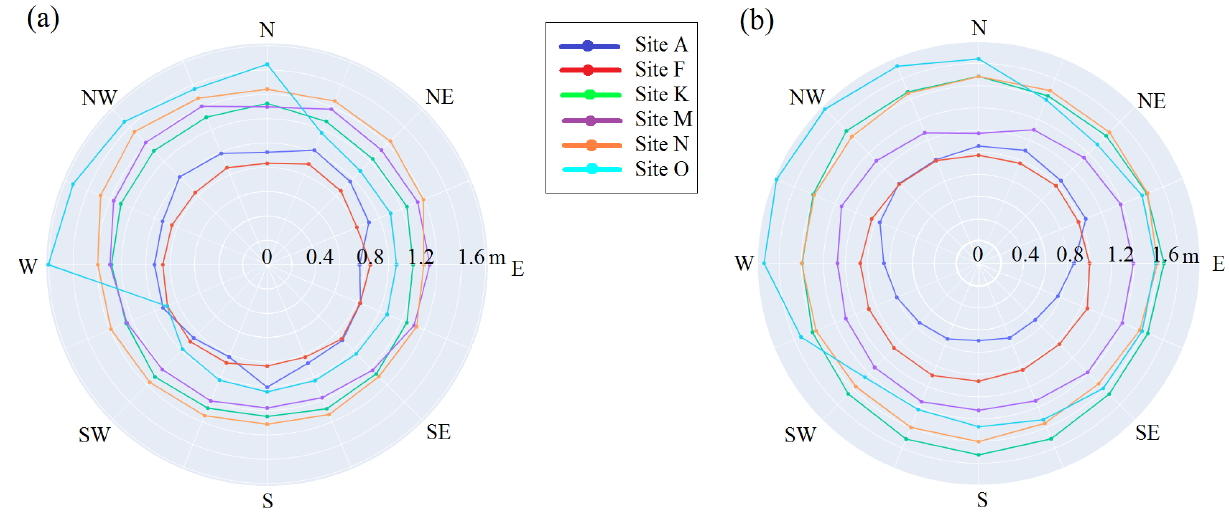
Figure 8. Under-the-canopy (a) and open-area (b) snow depth at different aspects.